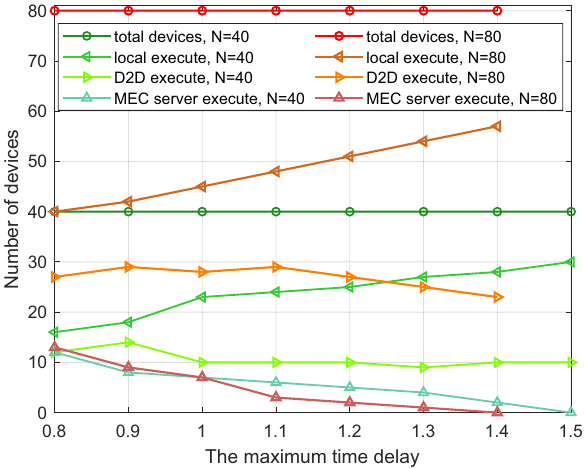
Figure 5. The number of devices versus the maximum time delay of different kinds.